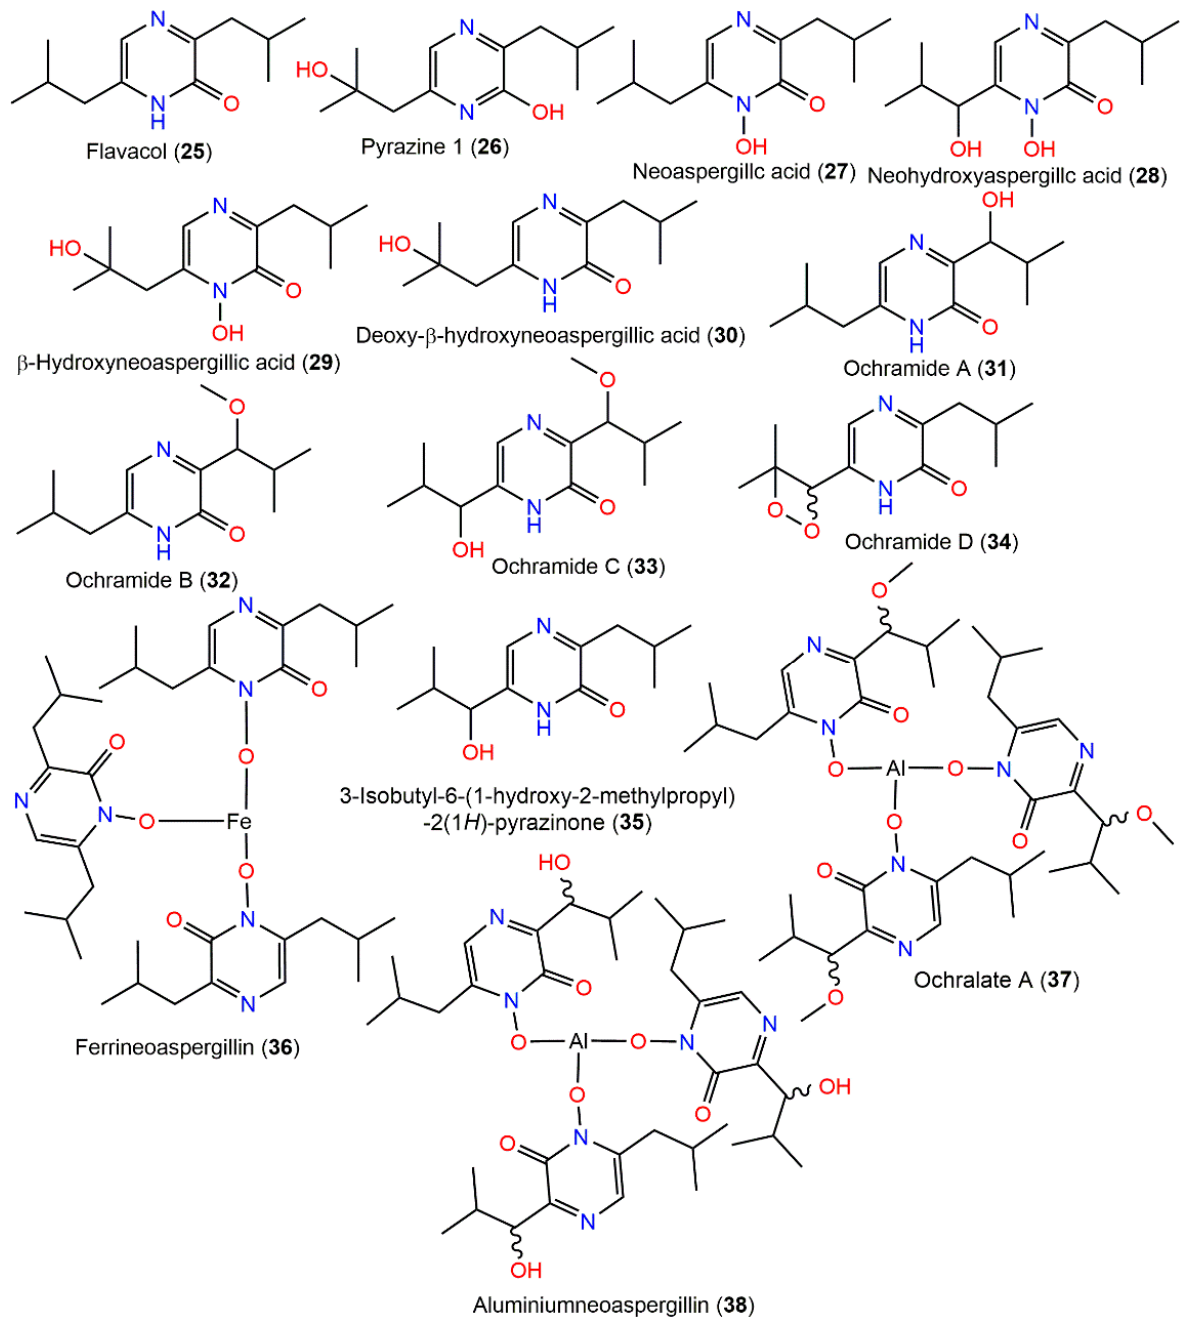
Figure 3. Pyrazine derivatives ( 25 – 38 ) reported from A. ochraceus.